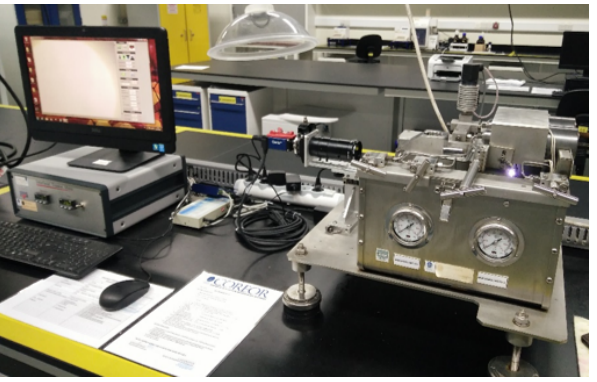
Figure 6. Interfacial tension meter (IFT 700) setting for measuring the contact angle